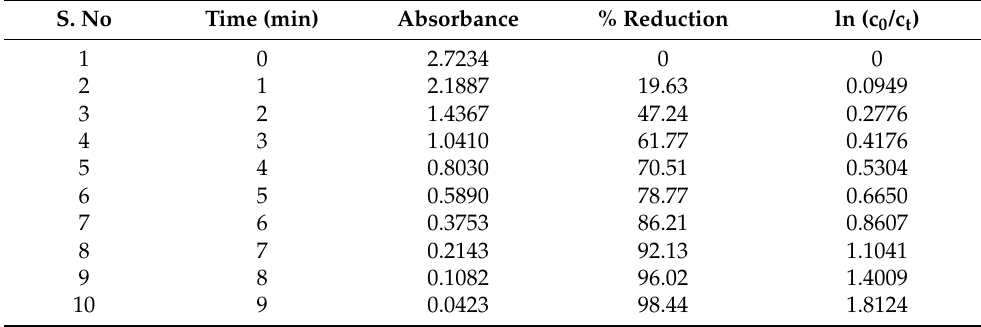
Table 2. Absorbance and % reduction with respect to time for 4-nitrophenol reduction.